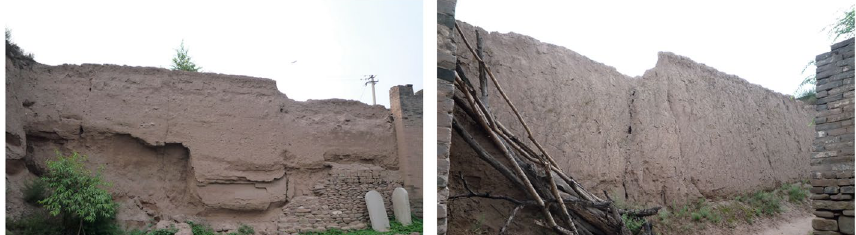
Fig. 15 Status quo of the south and north facades of the wall before restoration (Source: Tongji University, Ecole de Chaillot and China Academy of Art 2010)